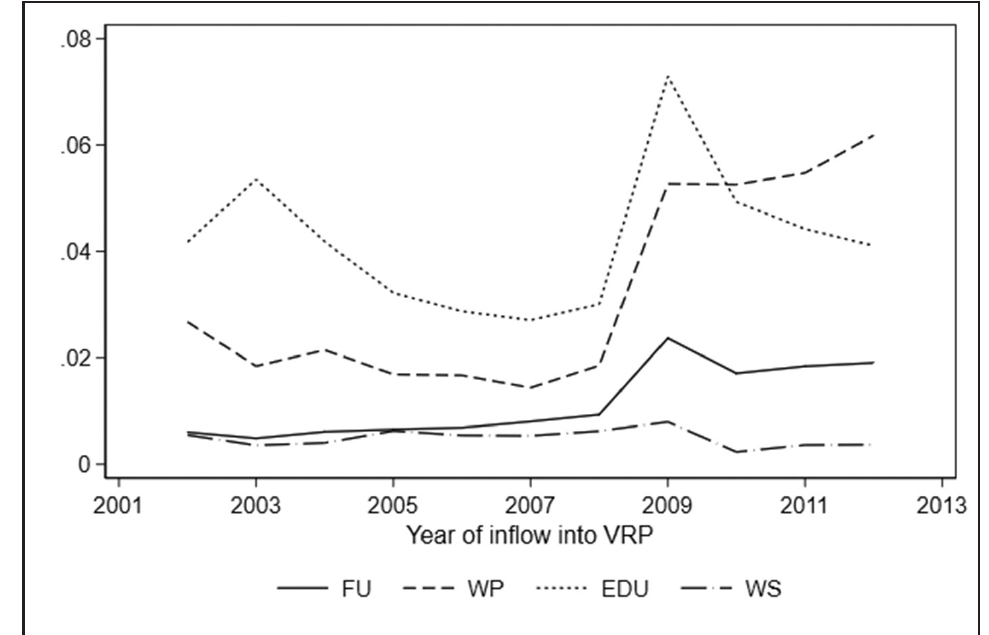
Figure 7 Yearly inflow into vocational rehabilitation program (VRP), as share of all ongo- ing work-impairment spells. Young people 18-29 years of age